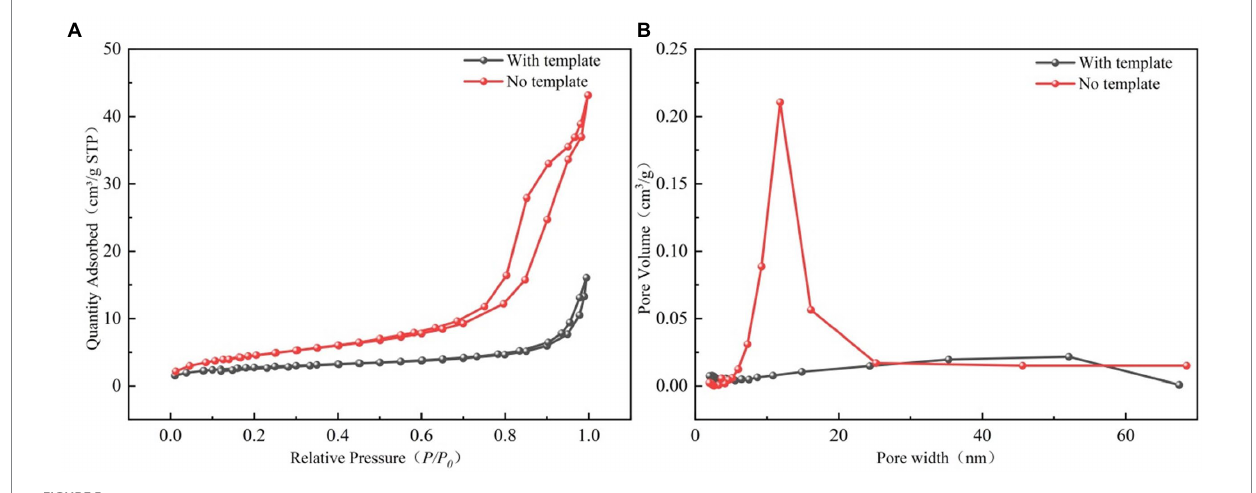
FIGURE 5 Nitrogen adsorption–desorption isotherms of the LBMs (A) , and mesopore size distributions of the LBMs using BJH model (B) .